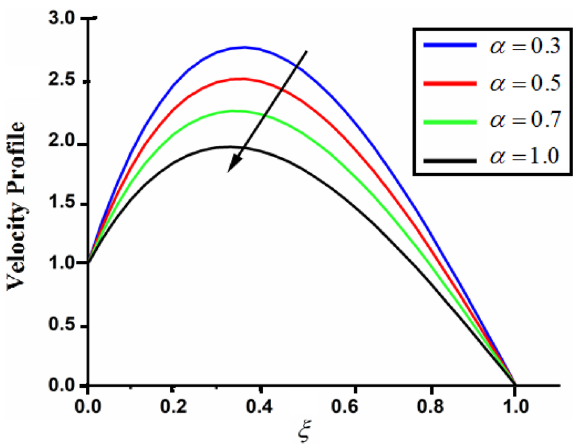
Figure 3. The impact of fractional parameter α on couple stress fluid velocity in channel when, β = 0.5 , Gr = 2 , Gm = 3 , M = 2 , K = 3 , η A = 1 , P = 1.5 , Pr = 1.5 , Re = 2.5 and Sc = 0.3 .